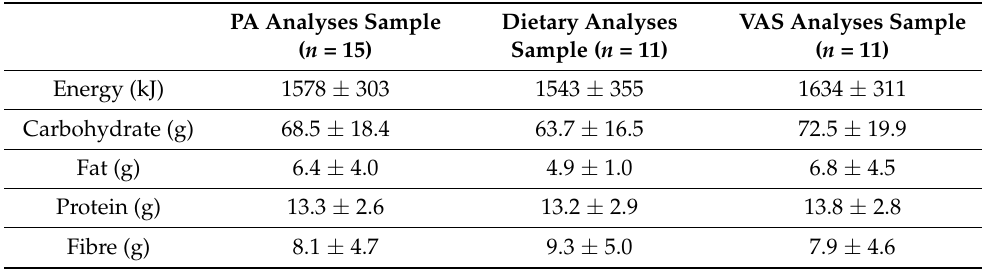
Table 2. Nutrient content of the breakfast providing 25% of individual resting metabolic rate to adolescent girls who participated in the randomised crossover trial that compared seven days of daily breakfast consumption (BC) with seven days of breakfast omission (BO) 1